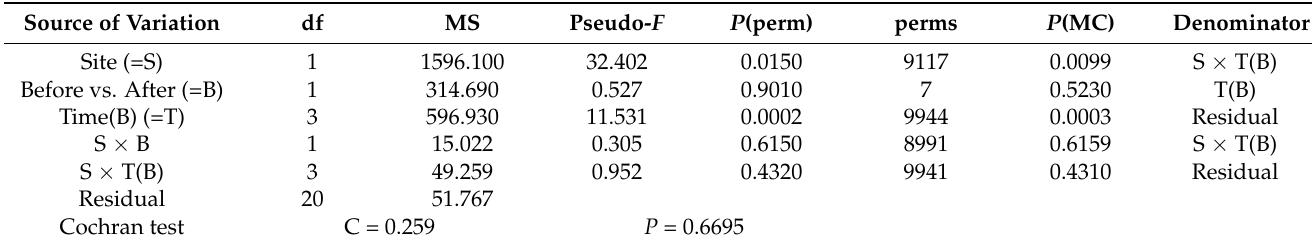
Table 5. PERMANOVA on species richness (S) of benthic assemblages of Treatment and Control sites at Before (T1, T2) and three After (T3–T5) the bioremediating action. Cochran’s C-test was used before each analysis to check for homogeneity of variance.